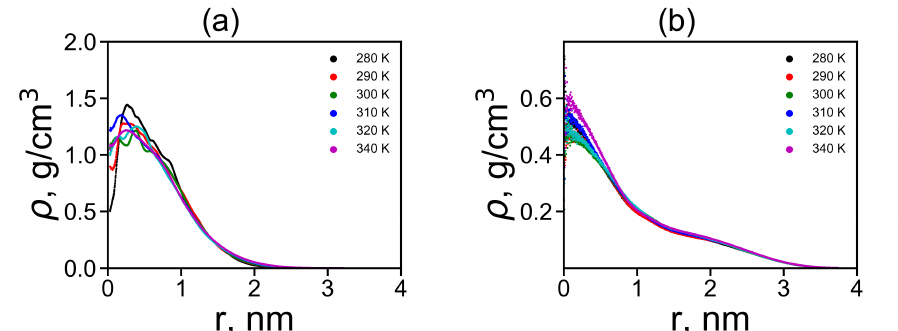
Figure 5. The radial distribution function of density for dendrimers at different temperatures: